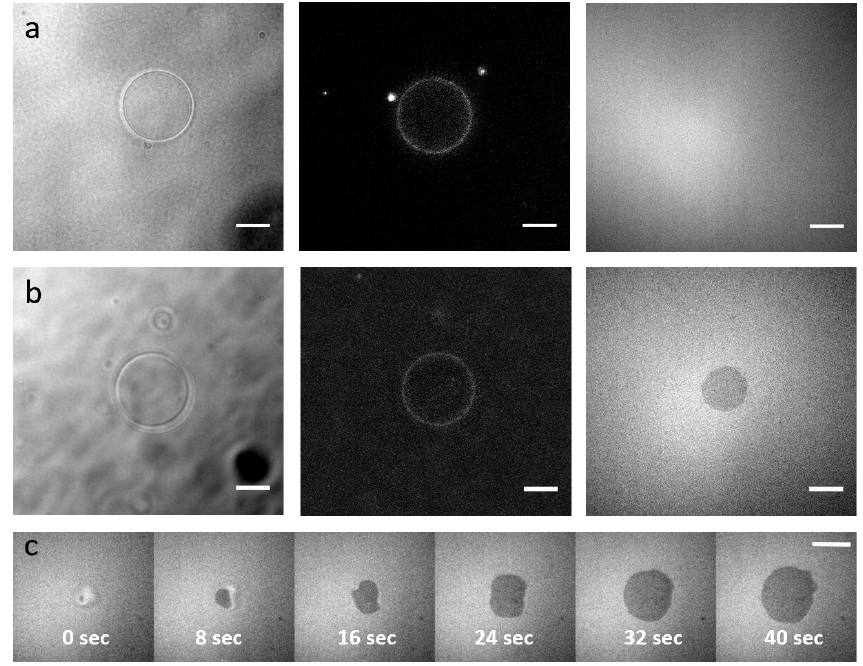
Figure 6. Functionality of the integrins. ( a , b ) pGUVs containing integrins are deposited on Supported Lipid Bilayers (SLBs) without RGD ligand of integrins ( a ) or with RGD ( b ). Left: Bright-field channel, GUVs. Middle: Epi-fluorescence channel showing integrin incorporation in the GUV. Right: RICM, dark regions indicate adhesion. ( c ) Timelapse of an integrin containing pGUV adhering to an RGD functionalized SLB (time is indicated). Scale bars: 10 µ